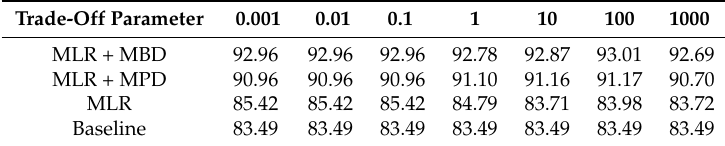
Table 16. MLR trade-off parameter discussion on MLV.